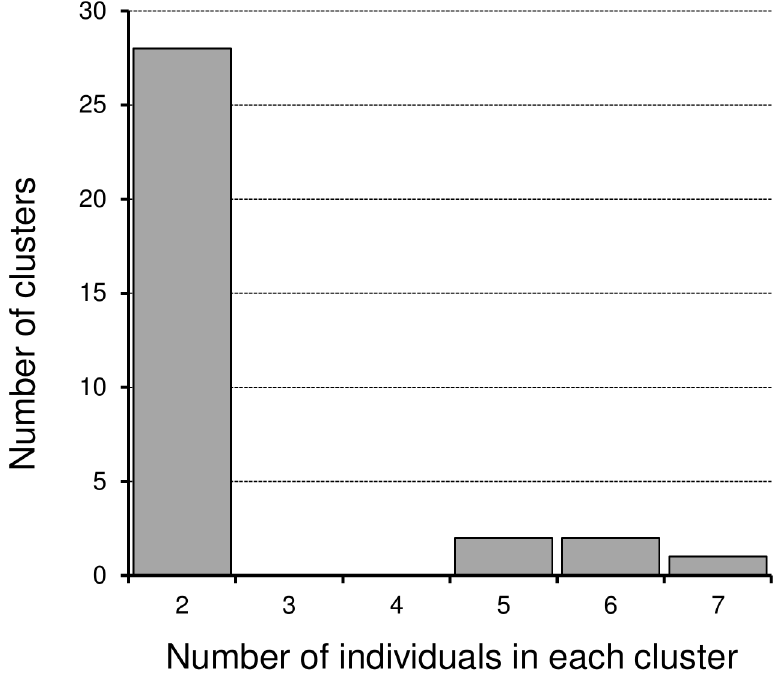
Figure 2. Histogram of CRF01_AE micro-clades by the number of individuals in each micro-clade. Twenty-eight micro-clades consisted of two patients and the remaining 5 micro-clades consisted of more than 4 individuals.